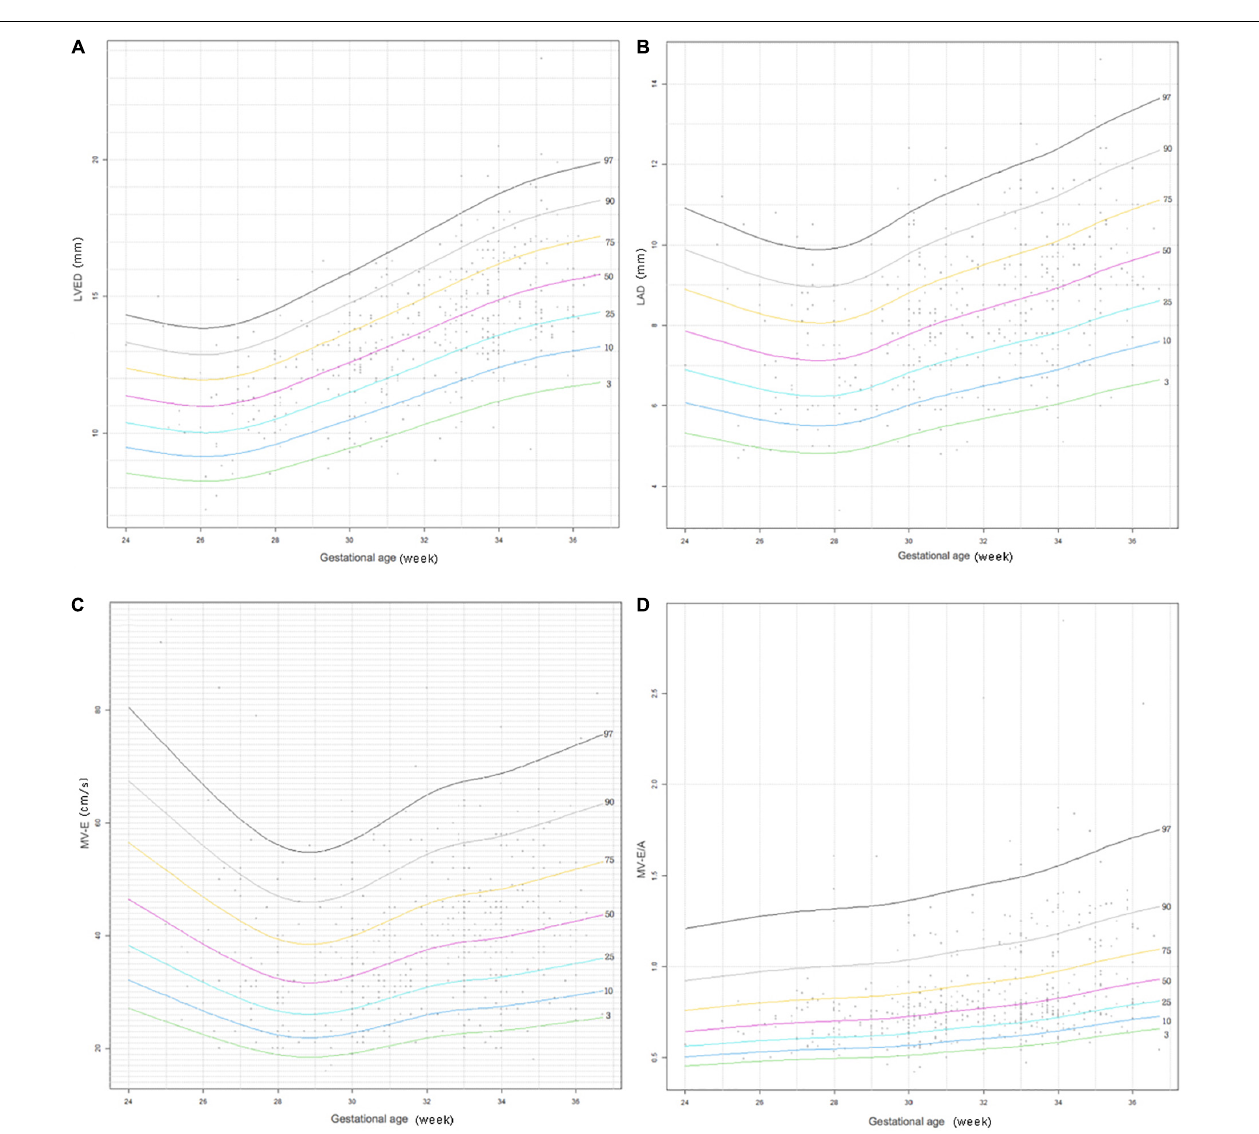
FIGURE 2 | Reference centile curve for 489 preterm infants generated using R language GAMLSS method for (A) left ventricular end-diastolic (LVED), (B) left atrium diameter (LAD), (C) the peak mitral valve flow rate E (MV-E), and (D) the peak mitral valve flow rate E to A (MV-E/A) normalized by gestational age within 7 days of